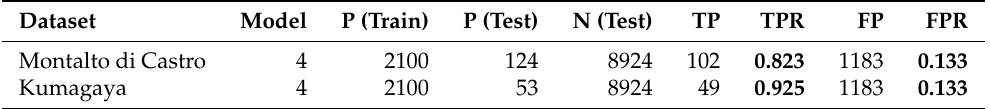
Table 3. Experiment 2: True positive rate (TPR) and false positive rate (FPR) for hotspot detection in thermal images. The R-CNN model was trained using an aggregated dataset and evaluated on a test dataset with ‘unseen’ PV sites.